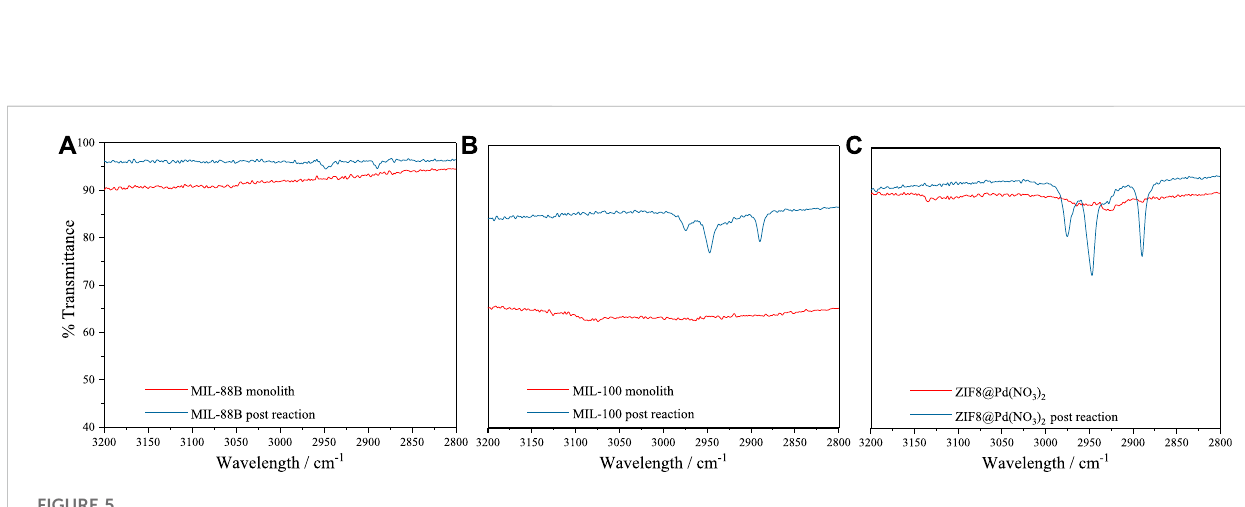
FIGURE 5 FT-IR spectra pre and post-reaction for (A) MIL-88B, (B) MIL-100, and (C) ZIF-8@Pd(NO 3 ) 2.